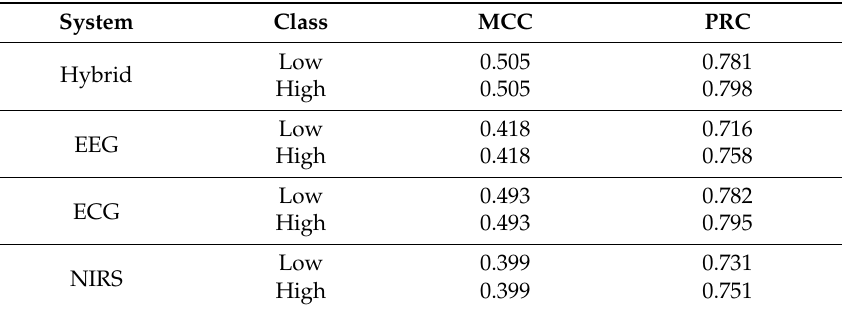
Table 11. Evaluation